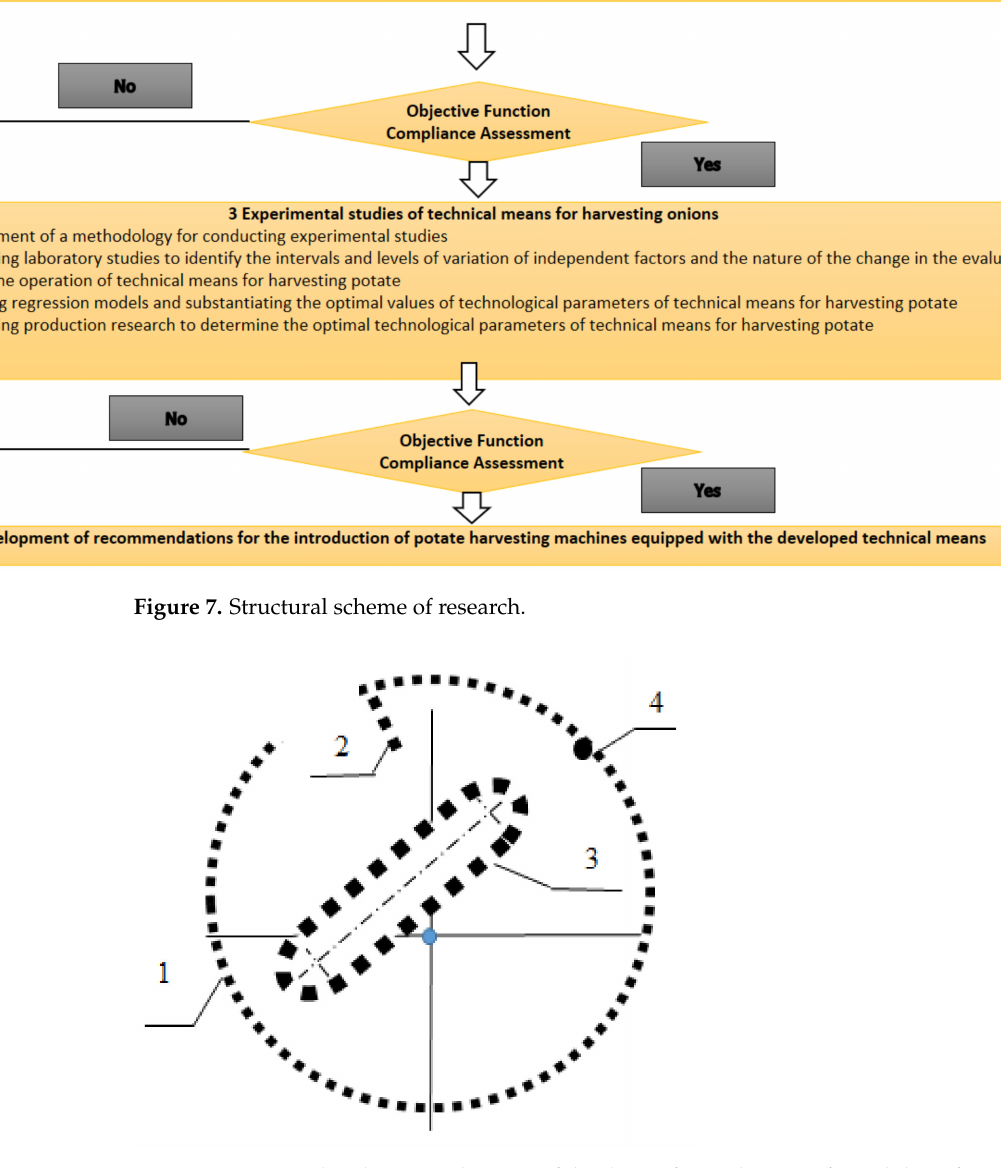
Figure 8. Structural and process diagram of the device for evaluation of suitability of potato varieties and hybrids for mechanized harvesting.:1—rod drum; 2—blade; 3—pin hummock;